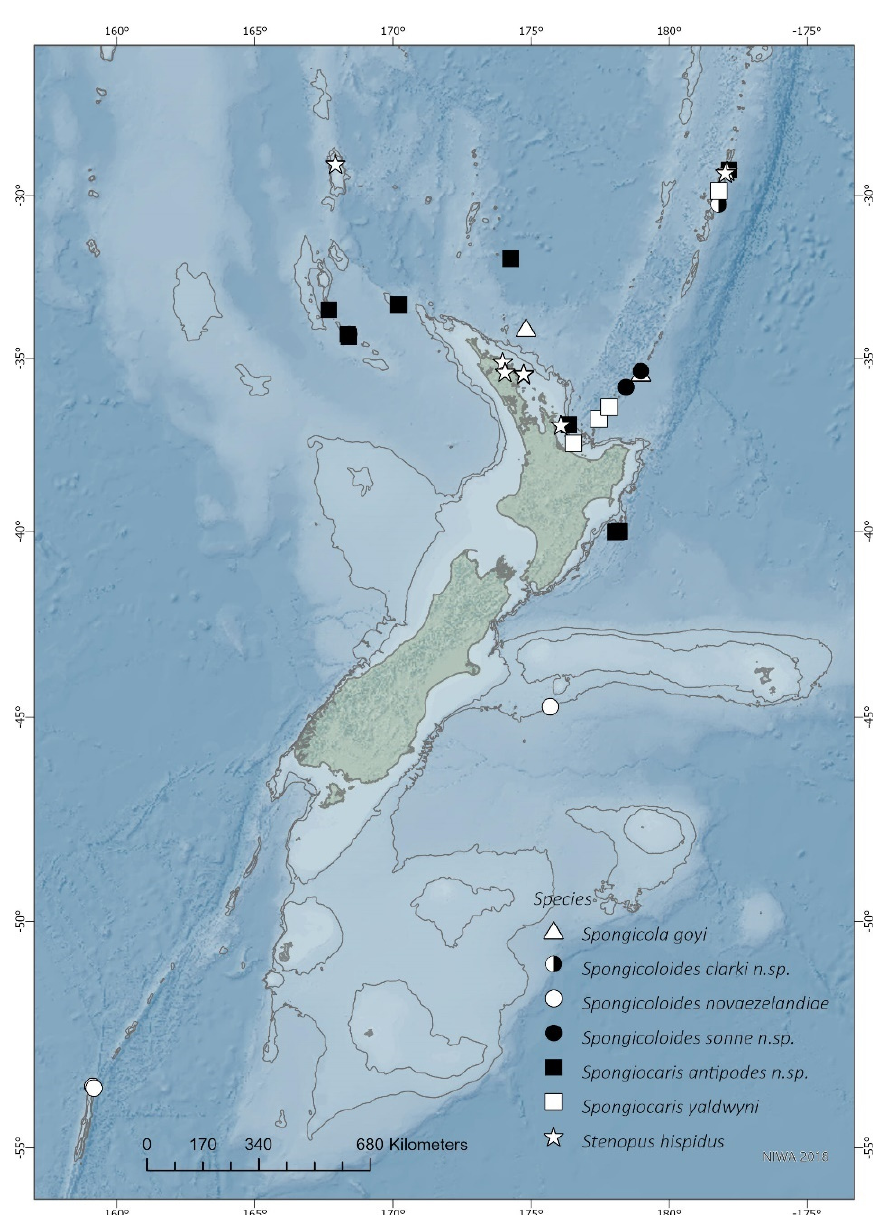
Figure 1. Map of the New Zealand region showing sampling locations for New Zealand Stenopodidea. 1000 and 2000 m bathymetric contours are highlighted.